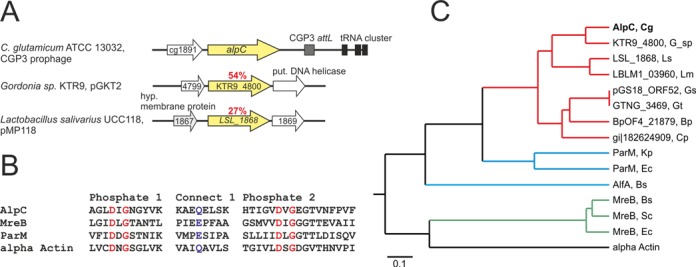
Genetic organization and phylogenetic analysis of AlpC. (A) Genetic organization of alpC and homologous proteins (yellow). (B) Alignment of the phosphate 1 (red), connect 1 (blue) and phosphate 2 (red) regions (57). The residues of C. glutamicum ATCC 13032 AlpC, B. subtilis MreB, E. coli ParM and human alpha actin are shown. Highlighted residues correspond to alpha actin D13 and G15 (red), Q139 (blue), and D156 and G158 (red). (C) Phylogenetic tree visualizing the relationship of AlpC homologs to bacterial actin-like proteins and human alpha actin. Branches shown in green indicate MreB proteins, branches colored in blue indicate plasmid partitioning ParM and AlfA proteins. AlpC and homologous proteins (red) are closer related to ParM. Amino acid sequences were aligned using the neighbor-joining method (ClustalW): AlpC Cg, C. glutamicum ATCC 13032 (gi|62390556), KTR9_4800 G_sp, Gordonia sp. KTR9 (gi|301321491), LSL_1868 Ls, Lactobacillus salivarius UCC118 (gi|90962843), LBLM1_03960 Lm, Lactobacillus mucosae LM1 (gi|377831150), pGS18_ORF52 Gs, Geobacillus stearothermophilus (gi|169636508) (plasmid-encoded), GTNG_3469 Gt, Geobacillus thermodenitrificans NG80-2 (gi|138898362), BpOF4_21879 Bp, Bacillus pseudofirmus OF4 (gi|288557196), Cp, Clostridium perfringens D str. JGS1721 (gi|182624909), ParM Kp, Klebsiella pneumonia (gi|146150982), ParM Ec, E. coli (gi|385721336), MreB Bs, B. subtilis (gi|255767642), MreB Sc, Streptomyces coelicolor (gi|21221069), MreB Ec, E. coli (gi|377940072), alpha actin, Homo sapiens (gi|178029).